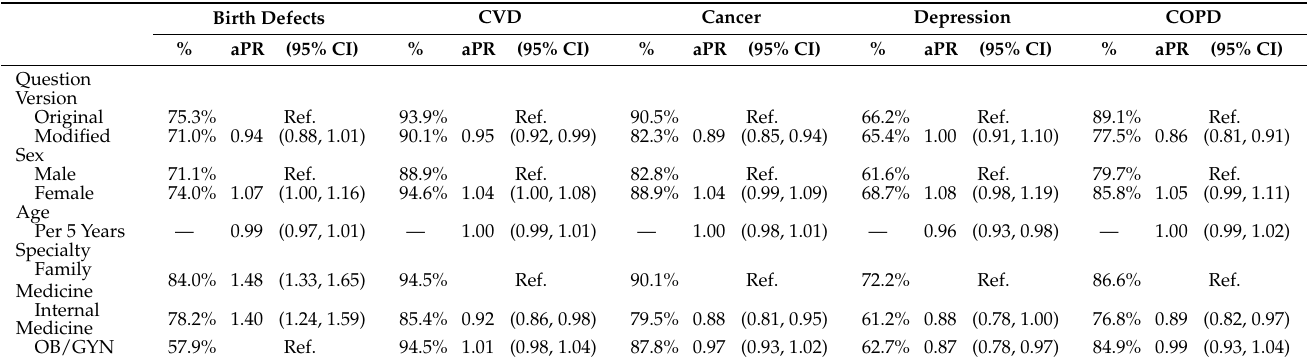
Table 4. Prevalence of and multivariable associations with “agreeing” or “strongly agreeing” that nicotine directly con- tributes to each health